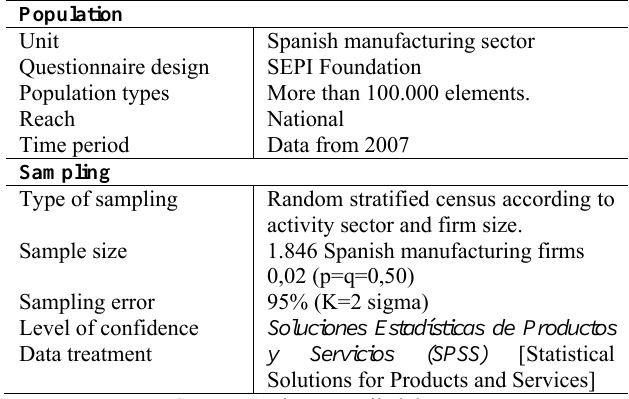
Table 1: Technical data from the